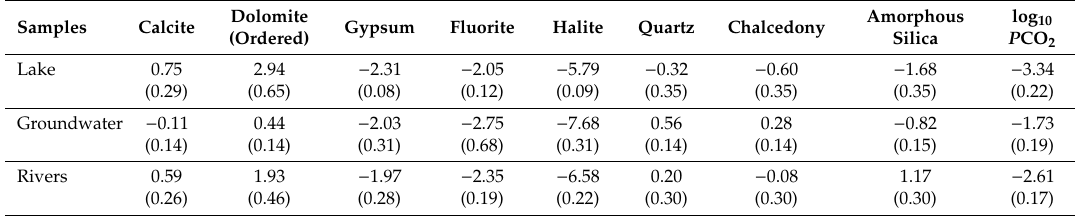
Table 1. Saturation indexes (SI)* with respect to relevant mineral phases and log P CO 2 . The average and the standard deviation values (in brackets) are reported for each